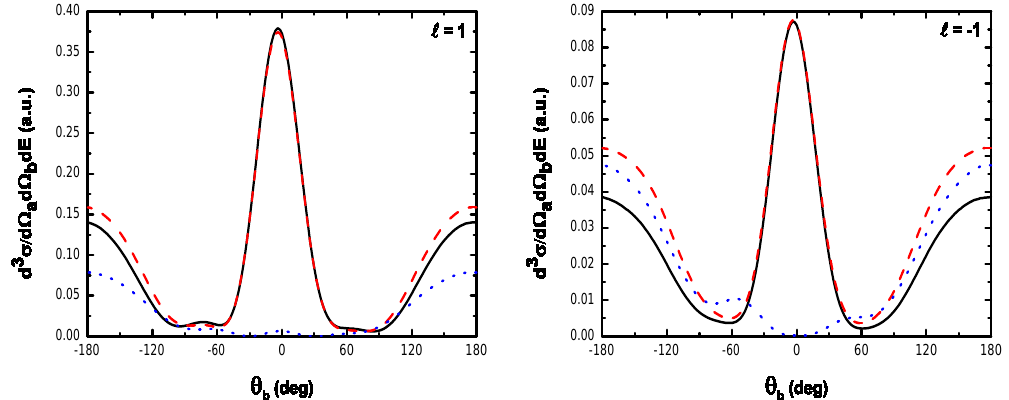
Figure 14. Triple differential cross sections corresponding to the laser-assisted electron-impact ionization process of atomic hydrogen as a function of the ejected angle θ b . The laser frequency ω = 1.17 eV and the electric field strength is E 0 = 10 7 V/cm. The incident electron energy is E k = 5 eV, and the scattering angle is θ a = 5 ◦ . The laser polarization of the ejected electron energy is E k b the field is set parallel to the incident momentum ( ˆ ε // k i ) .